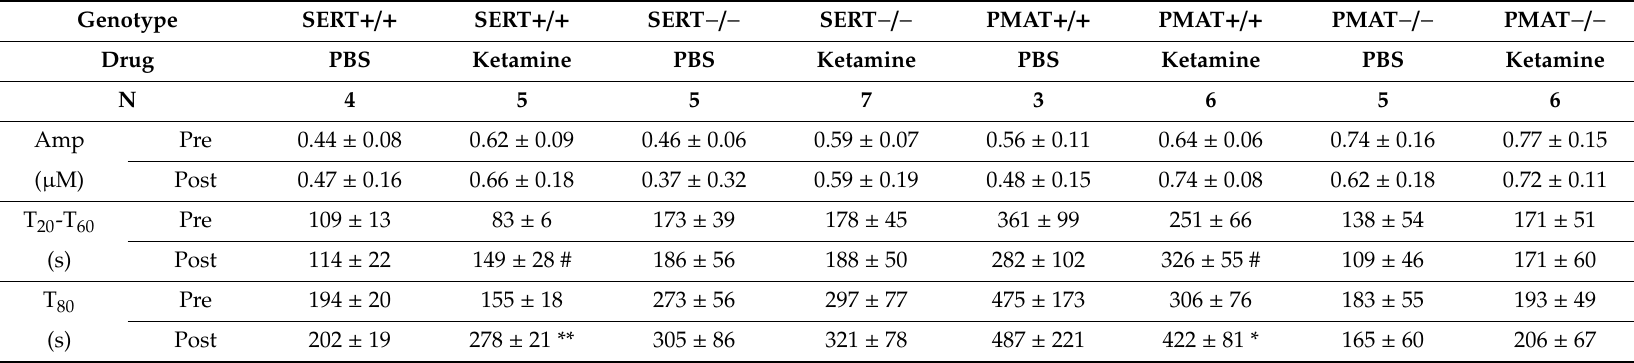
Table 1. Summary of pre- and post-serotonin signal amplitudes and time course (T 20 -T 60 and T 80 ) for serotonin clearance 2 min following pressure-ejection of phosphate bu ff ered saline (PBS) or ketamine into CA3 region of